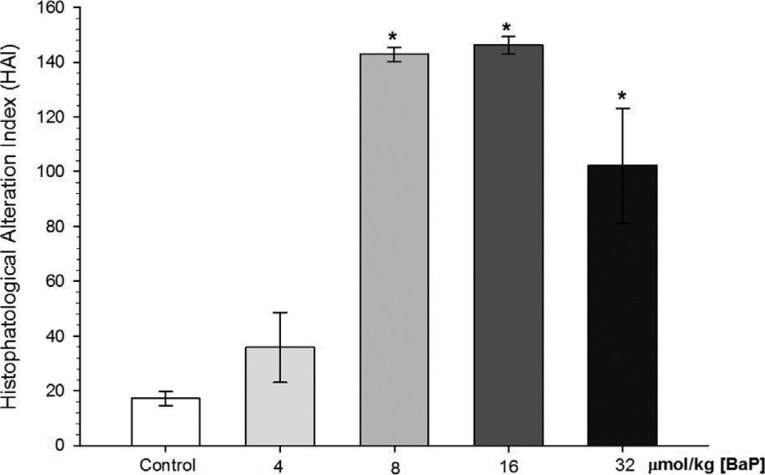
Histopathological alteration index (HAI) of C. macropomum
liver after exposure to different concentrations of B[a]P. Indexes are in
accordance with Poleksic and Mitrovic-Tutundic
(1994). *Indicates significant differences compared to control group
(corn oil) (p < 0.05). Kruskal-Wallis test was used.